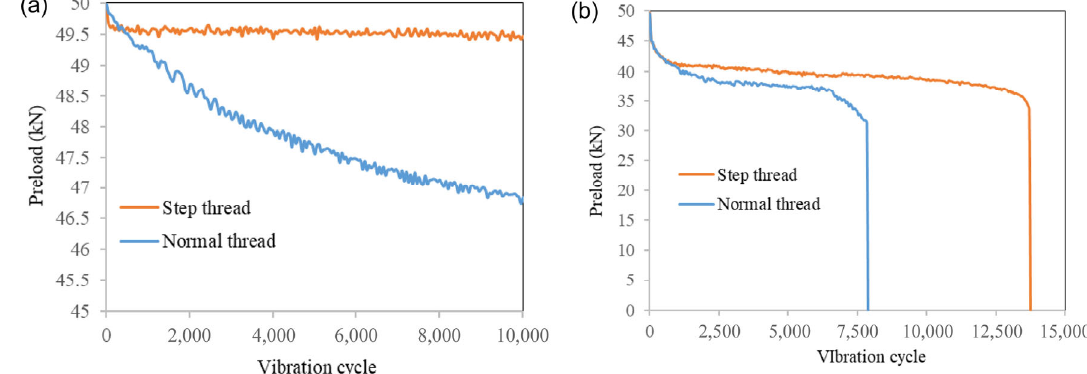
Fig. 23 Changes in preload with the increase in vibration cycles: (a) small amplitude; (b) large